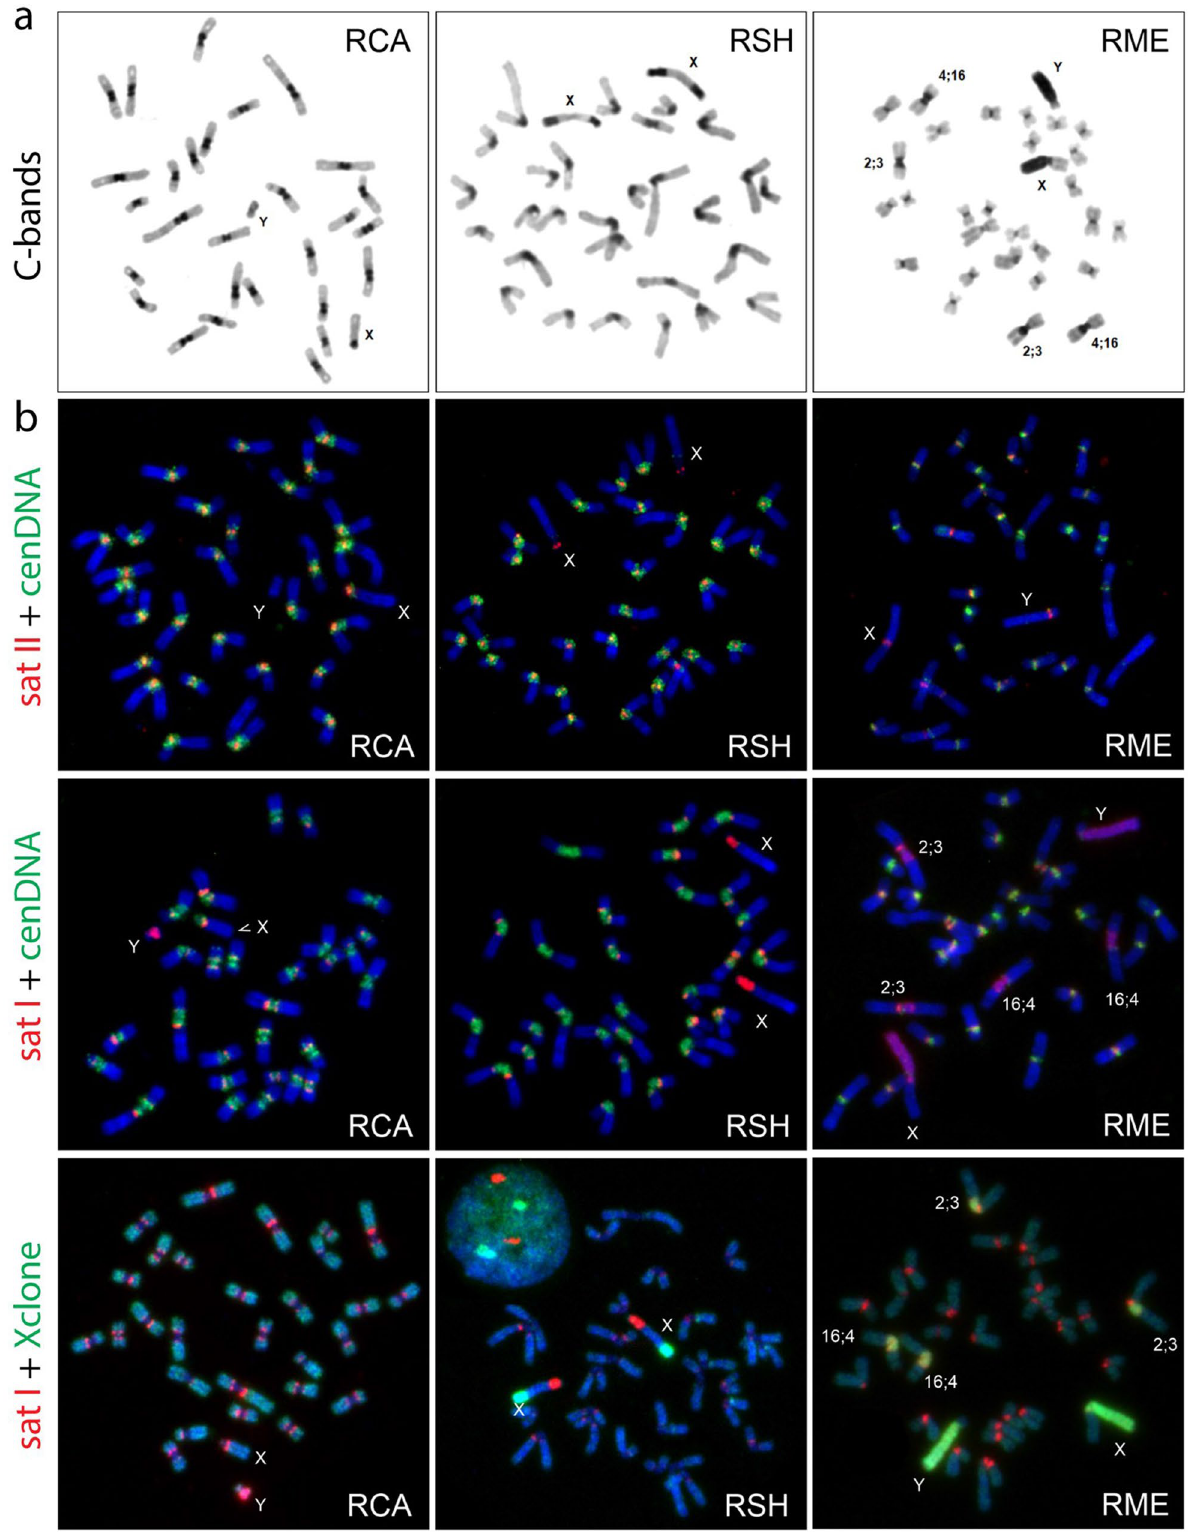
Figure 3. Molecular characterization of repeat sequences. ( a ) C-banding. Note the different locations of heterochromatic blocks on the X chromosomes and the relatively large amounts of pericentromeric heterochromatin in two fusion chromosomes Rb2;3 and Rb4;16 in RME. ( b ) FISH signals detected using satI, satII repeat probes and the microdissected cenDNA and Xclone probes in the three Raphicerus